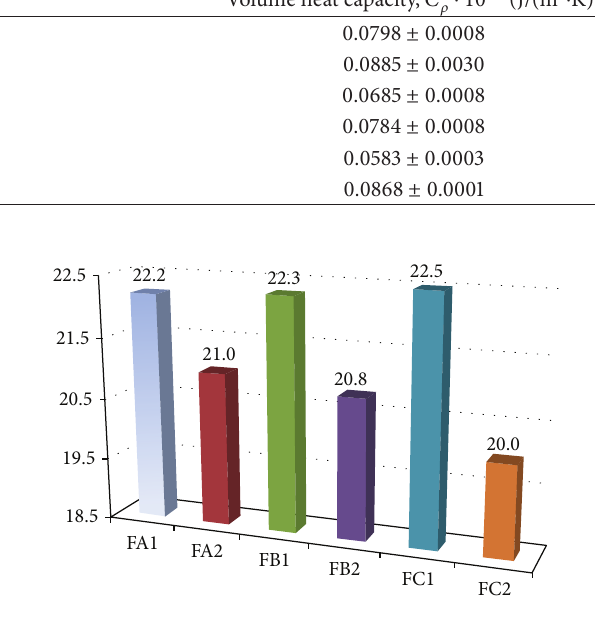
Figure 5: Foam oxygen index values